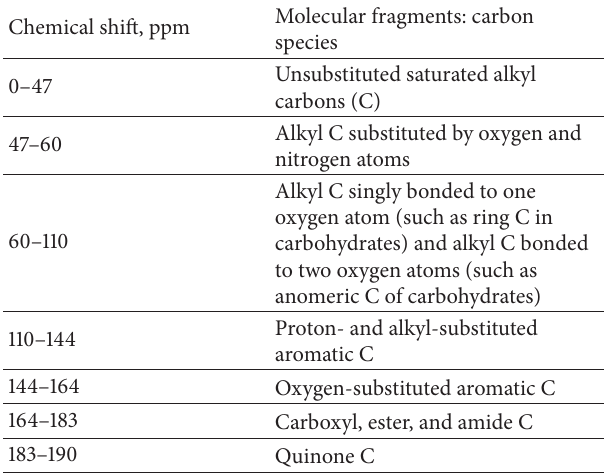
Table 1: Carbon species and chemical shifts via 13 C